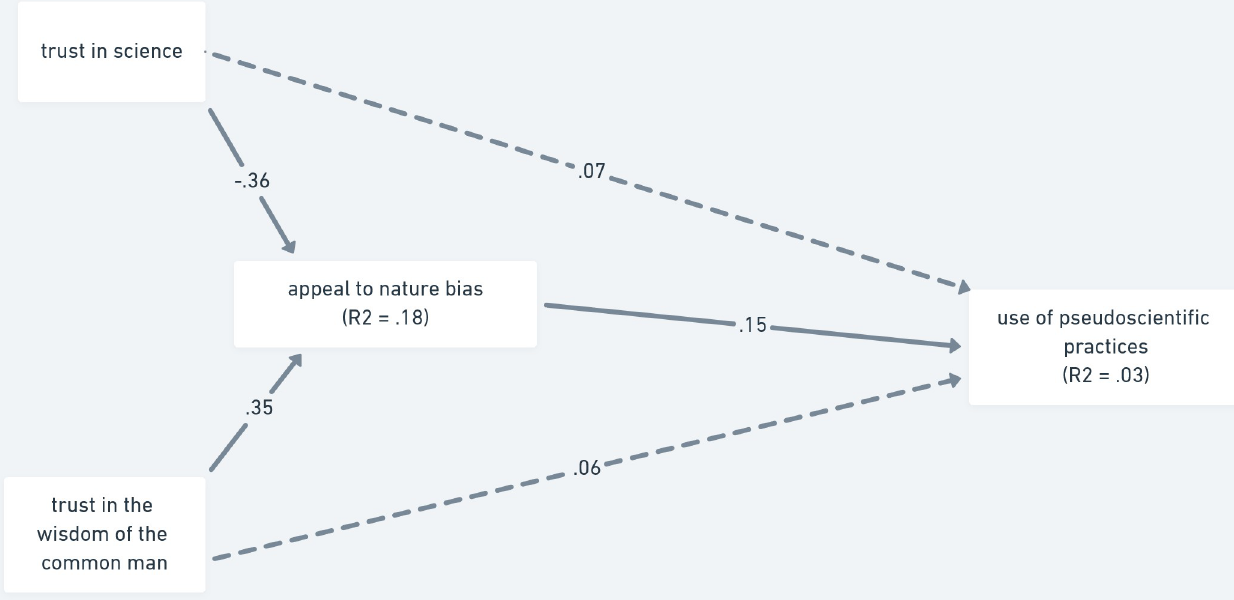
Fig 6. Mediation analysis of trust as a predictor of vaccination status via the appeal to nature bias—Study 2. Note . The paths are shown with standardized estimates. Non-significant paths are shown as dashed lines.